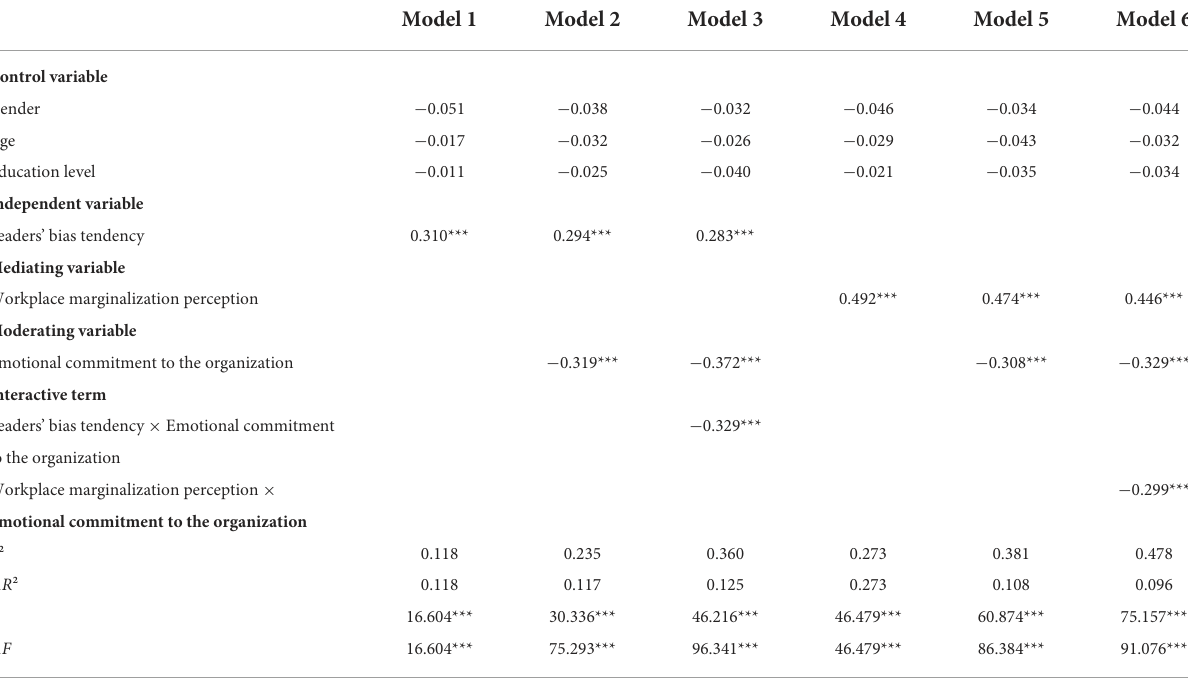
TABLE 5 Moderating effect